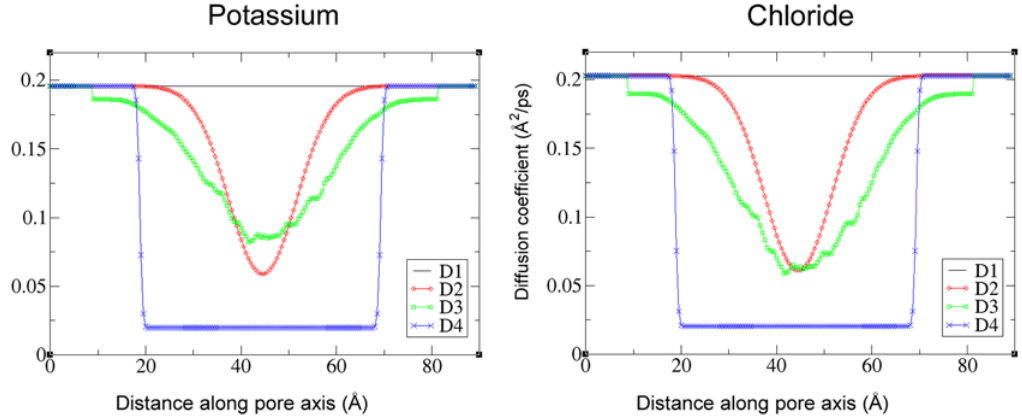
Figure 6. Ion diffusion coefficient profiles. All the profiles tested (D1–D4) are shown for both ions. Profile D3 is the only one that varies with the pore structure; the figure depicts diffusion coefficient profiles corresponding to the structure at 93.5 ns into the NPT segment of the MD simulations.